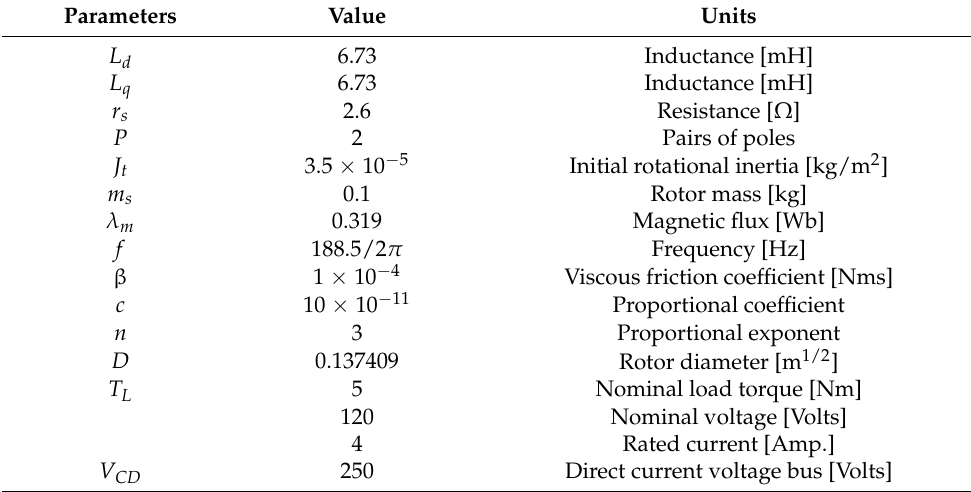
Table 1. Parameters for the PMSM model.